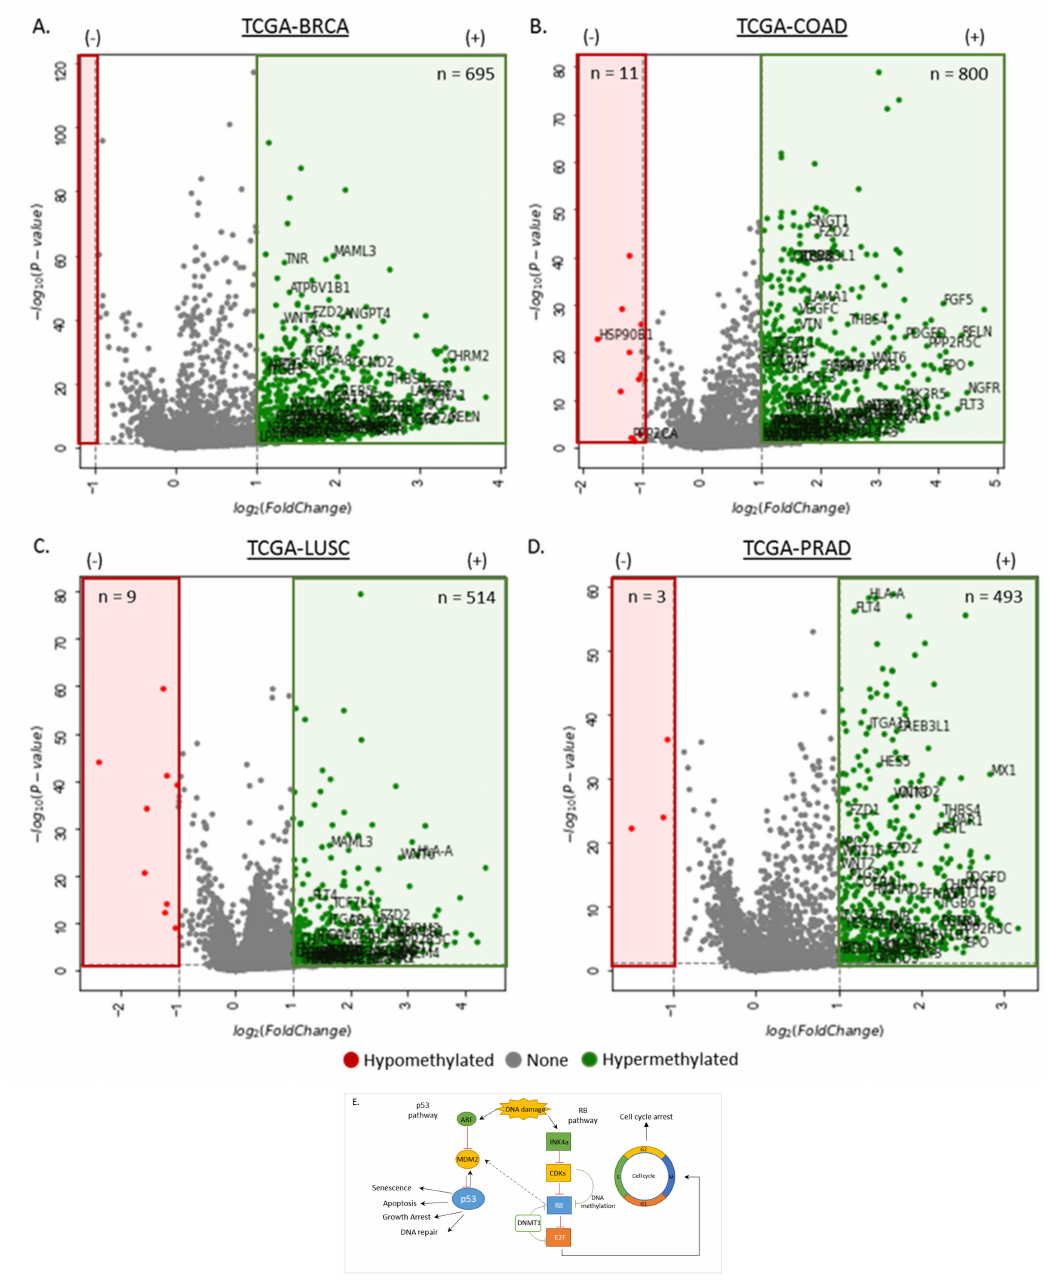
Figure 4. Hypermethylated genes in the dysregulation of the retinoblastoma (RB) tumor suppressor pathway in cancer. ( A – D ) Volcano plots showing the hypermethylation of breast (TCGA-BRCA; n tumor = 785, n normal = 95), colorectal (n tumor = 313, n normal = 38), lung (n tumor = 370, n normal = 42), and prostate cancers (n tumor = 502, n normal = 50) in the RB tumor suppressor pathway. The x-axis is log 2 fold change of DNA methylation (beta values), whereas the y-axis shows the − log 10 of the p values for each CpG site representing the strength of the association. Each point represents a CpG site. Dashed lines indicated cuto ff s for significance, where p < 0.05 and log 2 (Fold Change) > 1 (hypermethylation) or log 2 (Fold Change) < − 1 (hypomethylation). The number of hypermethylated CpGs in each cancer type is shown in green, and hypomethylated CpG sites are shown in red. ( E ) Schematic of the RB tumor suppressor pathway and its interaction with the p53 pathway. The p53 and RB pathway are two main tumor suppressor pathways that control cellular response to DNA damage and oncogenic stimuli. Each pathway consists of several regulators and e ff ectors. For simplicity, only four main components of each pathway are presented. In the RB pathway, stress signals such as DNA damage and